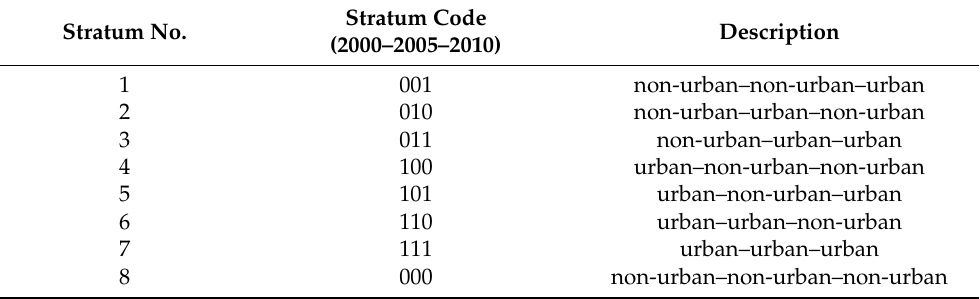
Table 5. The stratification design based on the multi-temporal land-cover change and no-change types, where 1 refers to urban land and 0 refers to non-urban. Stratum Stratum No.